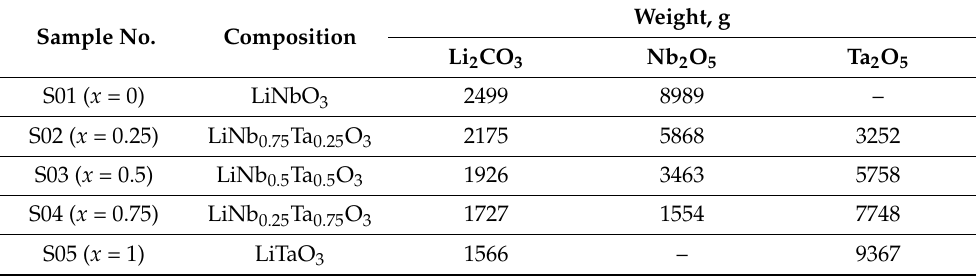
Table 1. Weights of reagents Li 2 CO 3 , Nb 2 O 5 , and Ta 2 O 5 , calculated to obtain 10 g of stoichiometric compounds LiNb 1 − x Ta x O